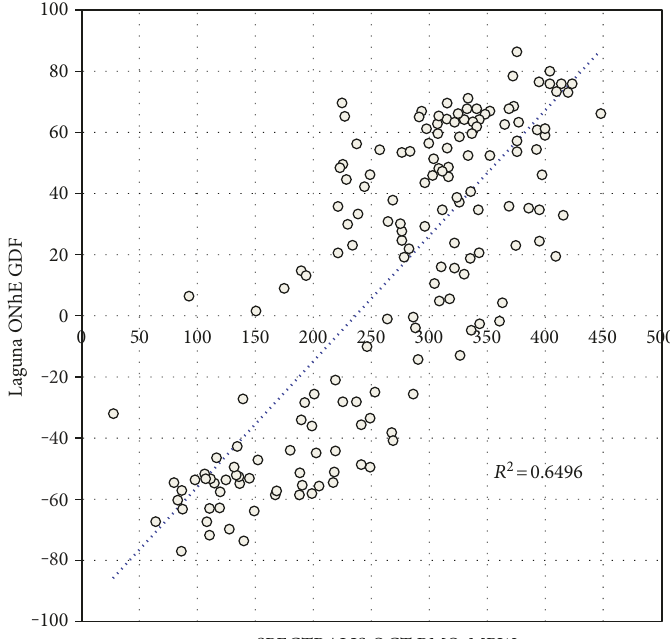
Figure 6: Scattergram of the BMO-MRW thickness that SPECTRALIS OCT measures in the neuroretinal rim, compared to the value of the glaucoma discriminant function (GDF) of the Laguna ONhE